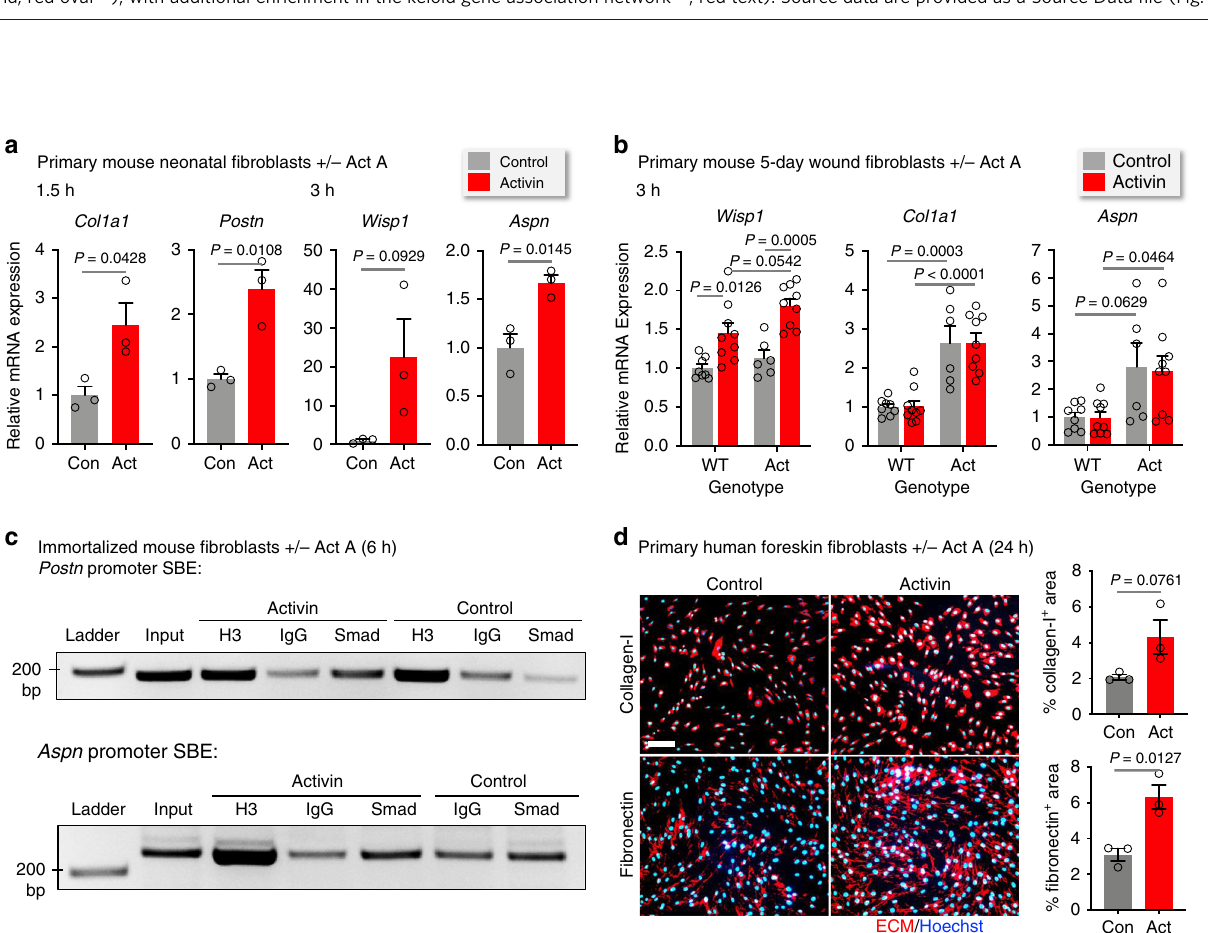
Fig. 3 Activin induces a pro- fi brotic gene expression signature in fi broblasts. a – d Genes regulated in 5dw vs NS fi broblasts and pre-ranked list of genes relatively up-regulated in Act 5dw/WT NS vs WT 5dw/WT NS (see Supplementary Fig. 3a, b) were subjected to GSEA against custom gene sets. NES and FDR values are shown. FDR are color-coded based on statistical signi fi cance (green). a Activin co-expression gene set derived from the SEEK database of multi-tissue gene expression datasets 32 . b Healing phase gene sets derived from microarray data of small excisional mouse wounds at different healing time points 34 . c Activated fi broblast gene sets include genes up-regulated in: (i) ɑ -SMA-positive myo fi broblasts from 12- or 26-day large excisional wounds 10 ; (ii) CD29 high , CD29 low , or adipocyte precursor myo fi broblasts from 5-day small excisional wounds 13 ; (iii) human keloid vs normal skin fi broblasts 35,36 ; (iv) matrix-forming vs normal pre-osteoblasts 37 ; and genes up- or down-regulated in scar-forming engrailed + vs engrailed − fi broblasts 9 . d Twelve wound fi broblast cluster gene sets identi fi ed by single-cell RNA sequencing of fi broblasts from 12-day large excisional wounds 14 . e , f Genes relatively up-regulated in 5dw of Act mice were subjected to IPA. Selected annotated cell functions ( e ) and ECM functions ( f ) were extracted and are shown with respective activation Z -scores and numbers of input genes enriched in the respective functions (# genes). P value < 1.0E-06 for all shown functions. g Top activin-regulated genes (at least 5% change vs WT NS) were subjected to functional enrichment analysis using enrichR, and the top fi ve Reactome terms are shown with respective FDR values. h Top activin-regulated genes (more than 5% change vs WT) were fi ltered by the Matrisome database. Left: Top up-regulated (in 5dw vs NS, log 2 FC > 3, FDR < 0.05) ECM genes are shown with respective Matrisome category, average log 2 FC (5dw vs NS), and the relative increase in upregulation in Act vs WT 5dw fi broblasts (Act + % change). Numerical values are color coded based on magnitude (red background). Right: Genes in red are associated with the collagen biosynthesis pathway. i Venn diagram comparison of activin-regulated ECM genes (orange oval) and genes signi fi cantly overexpressed in keloids 46 (blue oval) and in a murine hypertrophic scar model (6-day wound, green oval; 14-day wound, red oval 47 ), with additional enrichment in the keloid gene association network 48 , red text). Source data are provided as a Source Data fi le (Fig. 3).